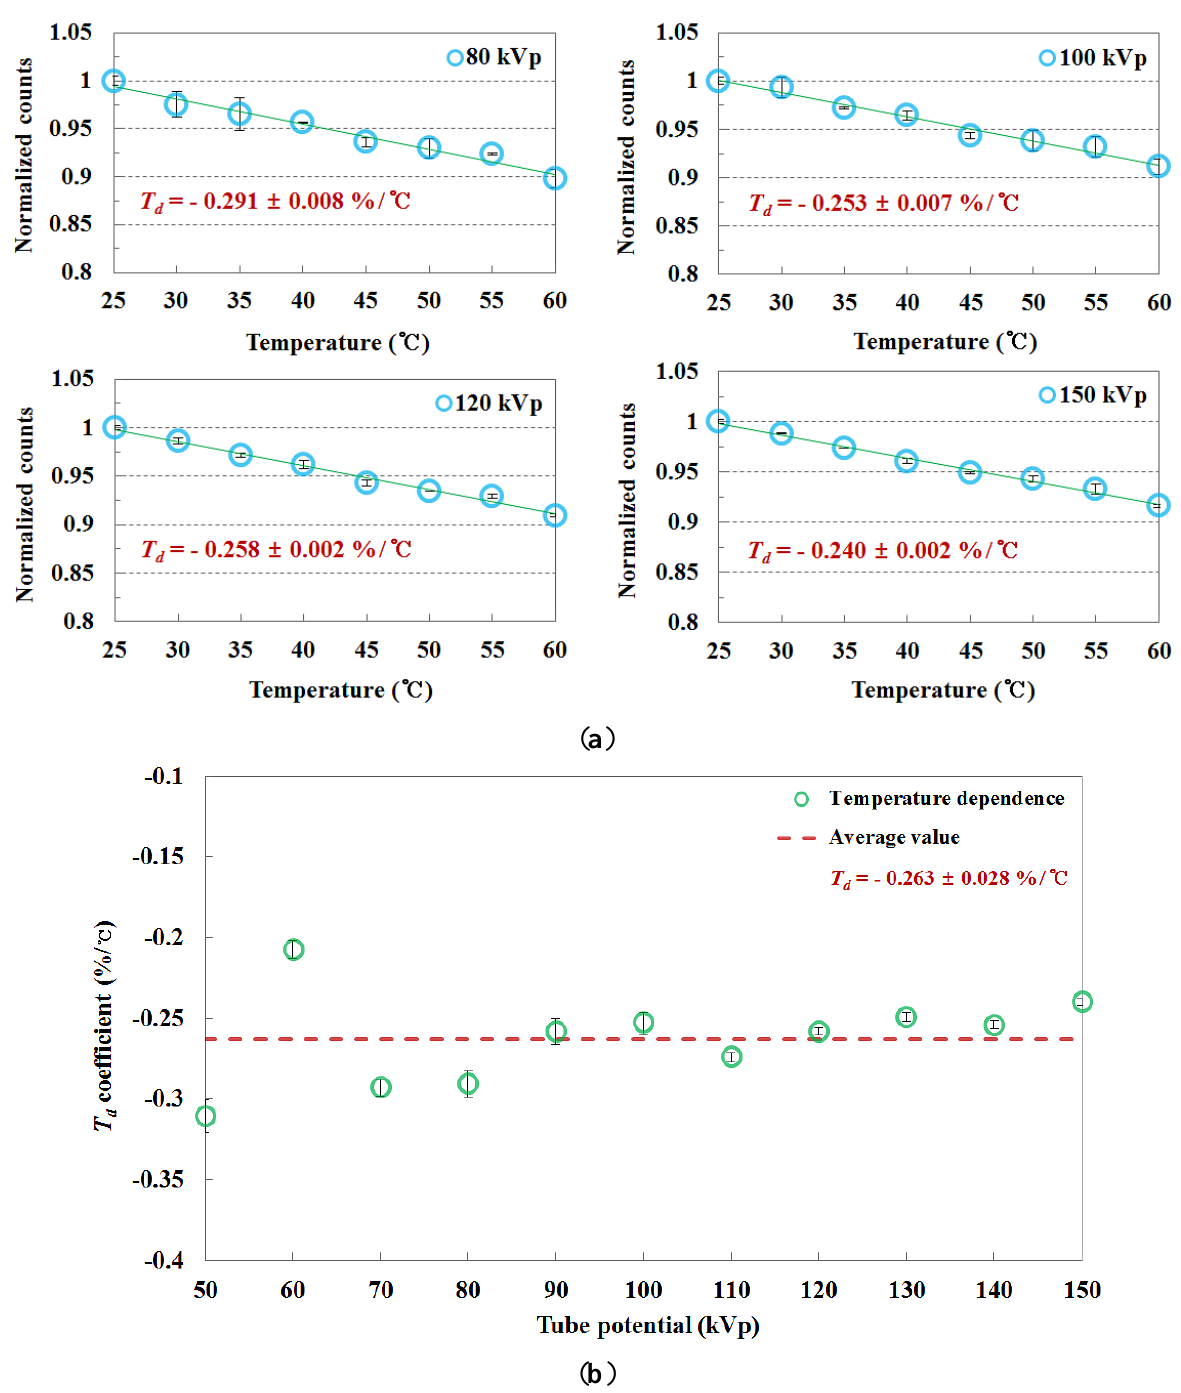
Figure 9. ( a ) Relationship between the temperature of the water and the normalized counts of the FOD when the tube potentials are 80, 100, 120, and 150 kVp, respectively; ( b ) T coefficients of the PSF at each tube